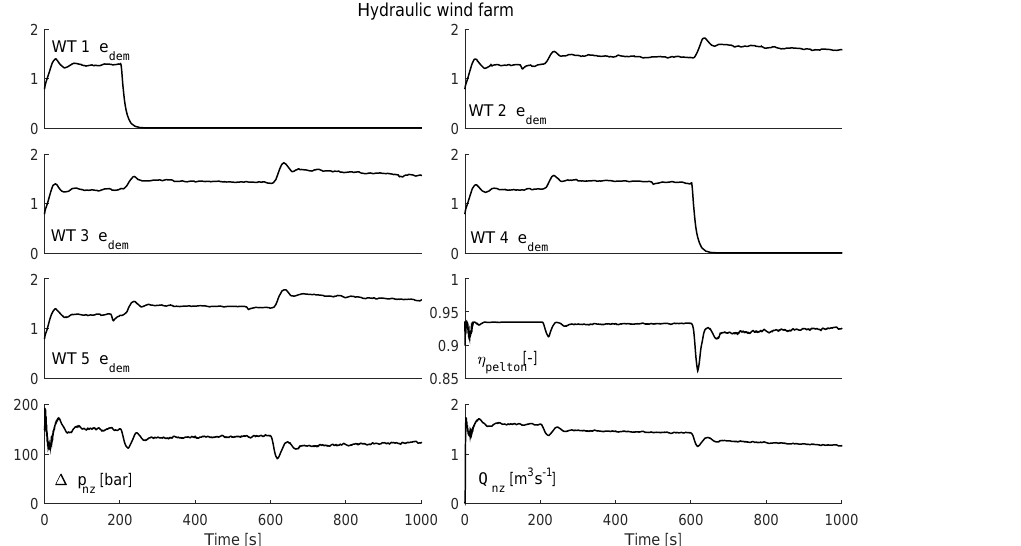
Figure 19. Operating parameters of a hydraulic wind farm subject to a wind field with a mean speed of 15ms − 1 and 12% turbulence intensity and full stop of turbines WT1 and WT4 at 200 and 600s